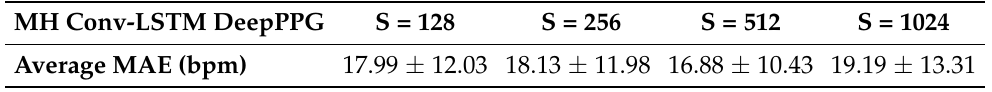
Table 6. Results for different fully connected layer